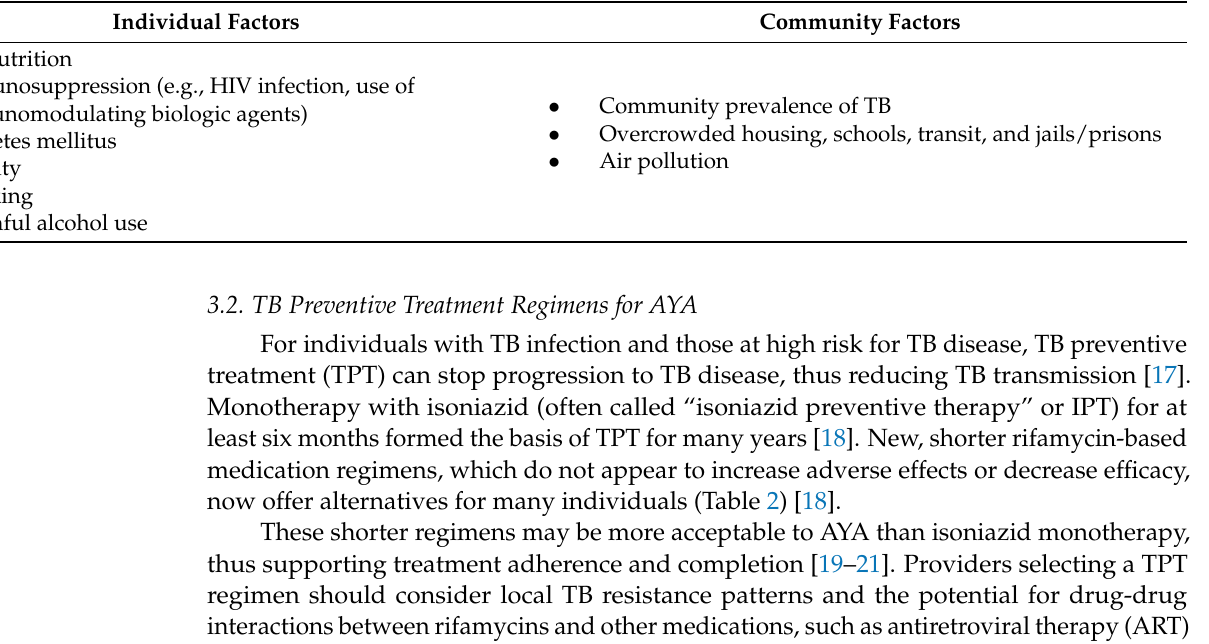
Table 1. Risk Factors for TB Infection and Progression to Disease in Adolescents and Young Adults. Individual Factors Community